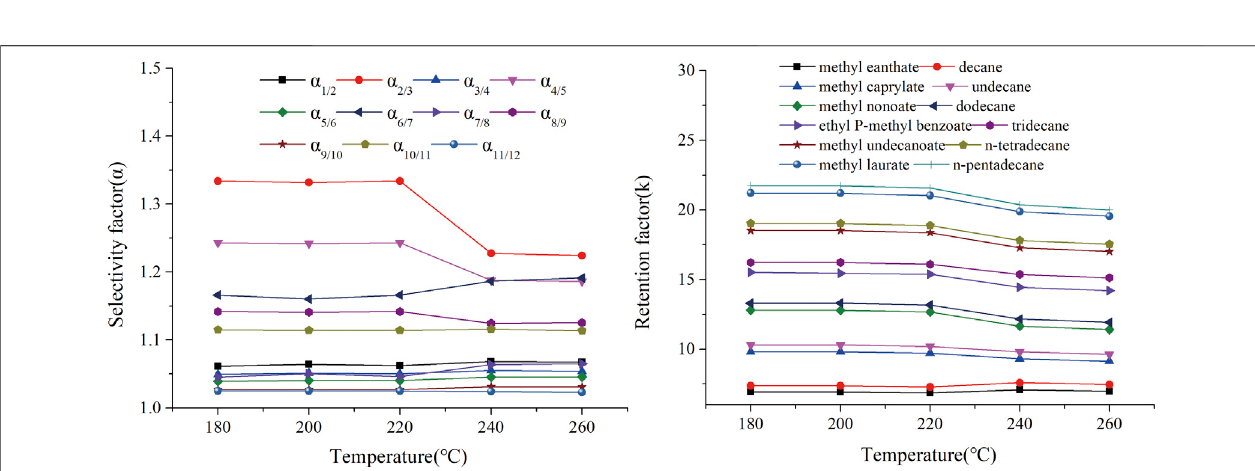
FIGURE12| Effect ofconditioning temperature ontheretentionfactor (k)and selectivityfactor ( α )ofn-alkaneand estermixtures onTPPcolumn. Peaks:(1)methyl heptanoate, (2) decane, (3) methyl caprylate, (4) undecane, (5) methyl nonaoate, (6) dodecane, (7) p-methyl ethylbenzoate, (8) tridecane, (9) methyl undecanate, (10) n-tetradecane, (11) methyl laurate, (12) n-pentadecane.